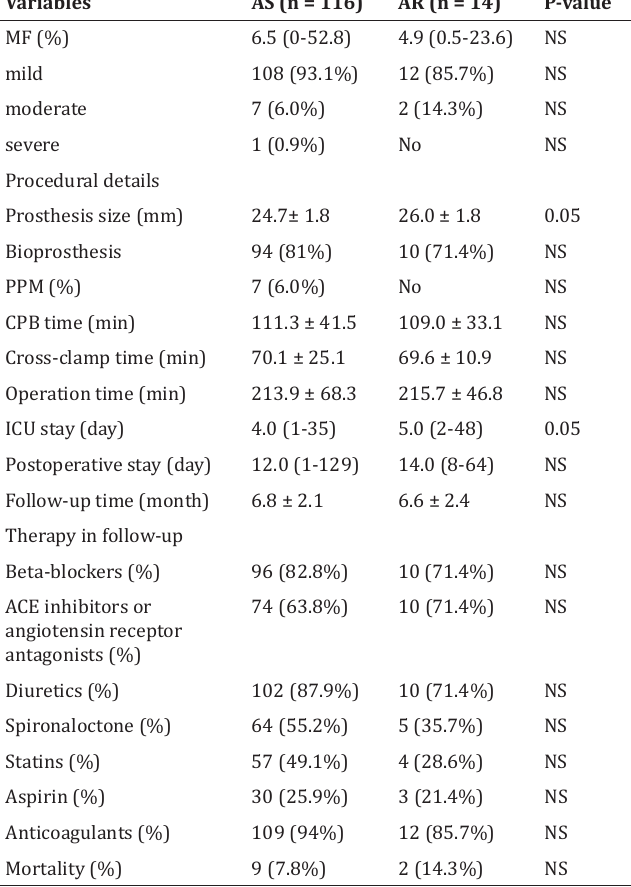
Intraoperative and postoperative results